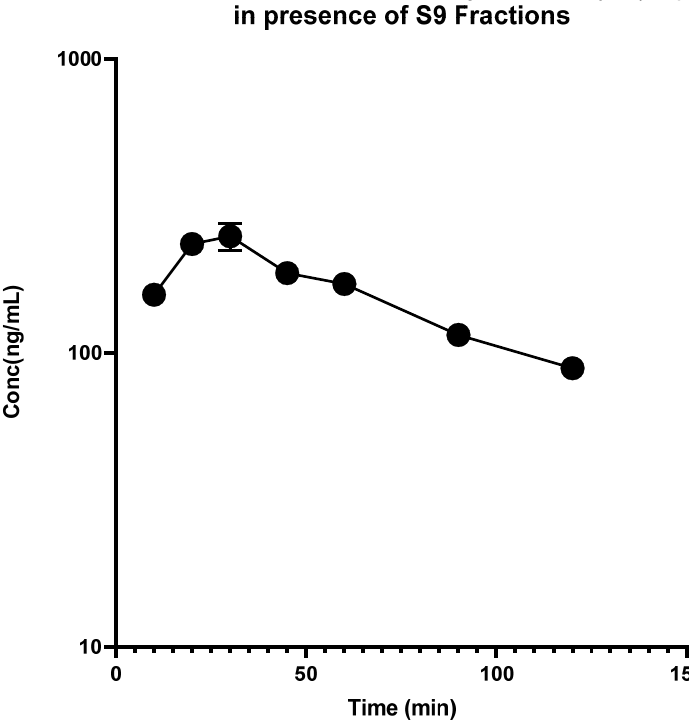
Figure 3. Time-dependent formation of linalool from linalyl acetate in human liver microsomes. Human liver microsomes were incubated with linalyl acetate (10 µM) for 0–120 min in the presence of cofactors. The data are expressed as mean ±SEM.